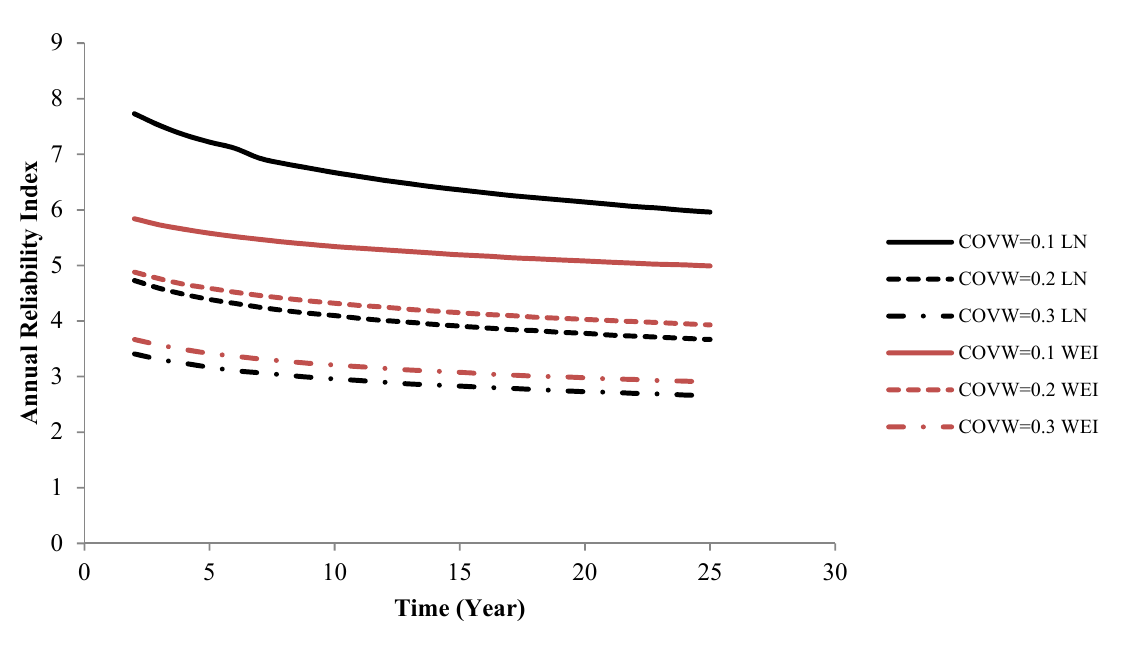
Figure 6. Annual reliability index for different uncertainty models for X W . Test D21 T95 R = −